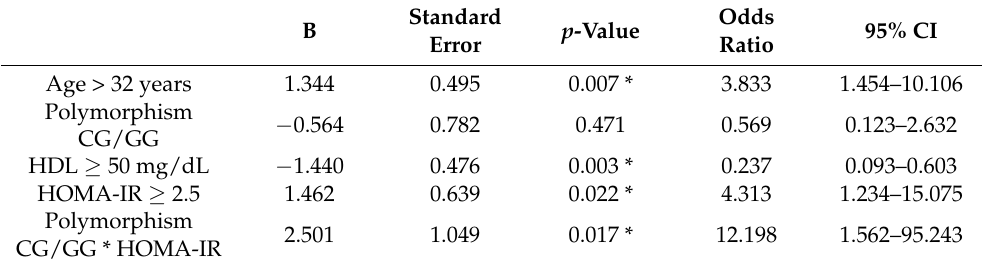
Table 2. Beta coefficients (B), standard errors, p -values, odds ratios and confidence intervals (95% CI) for NAFLD prediction.